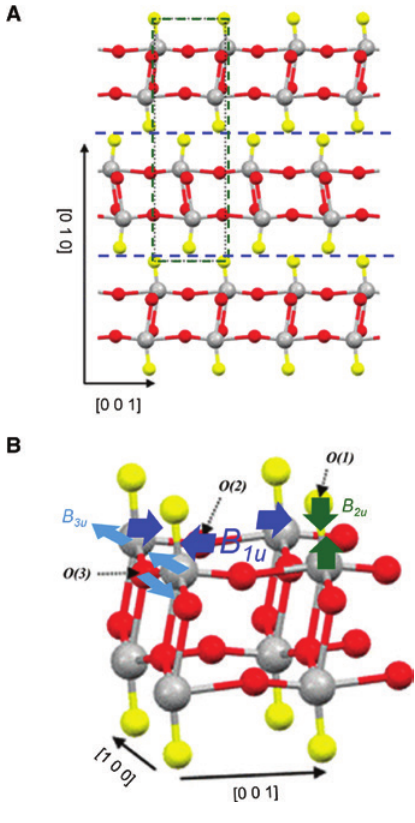
. Figure 8: Structure and IR active phonon modes of α -MoO 3 (A) The unit cell of the α -MoO structure is designated with the 3 green-dotted box. The blue-dashed lines enclose one α -MoO layer 3 that interacts with the adjacent layers with weaker vdW forces. (B) Magnified part of an α -MoO layer: the three in-equivalent O atoms 3 and associated asymmetric stretching vibrations are indicated. [Figure reprinted (adapted) with permission from [130].